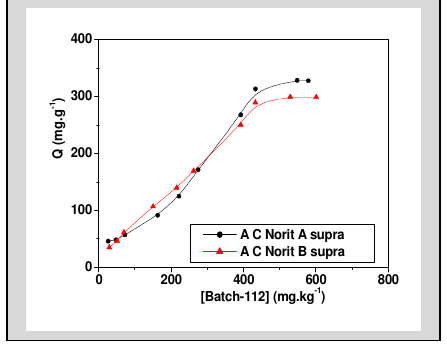
Fig. 5. Adsorption Isotherm of chitosan (batch-112) on the activated carbons; pH = 4 and T = 298